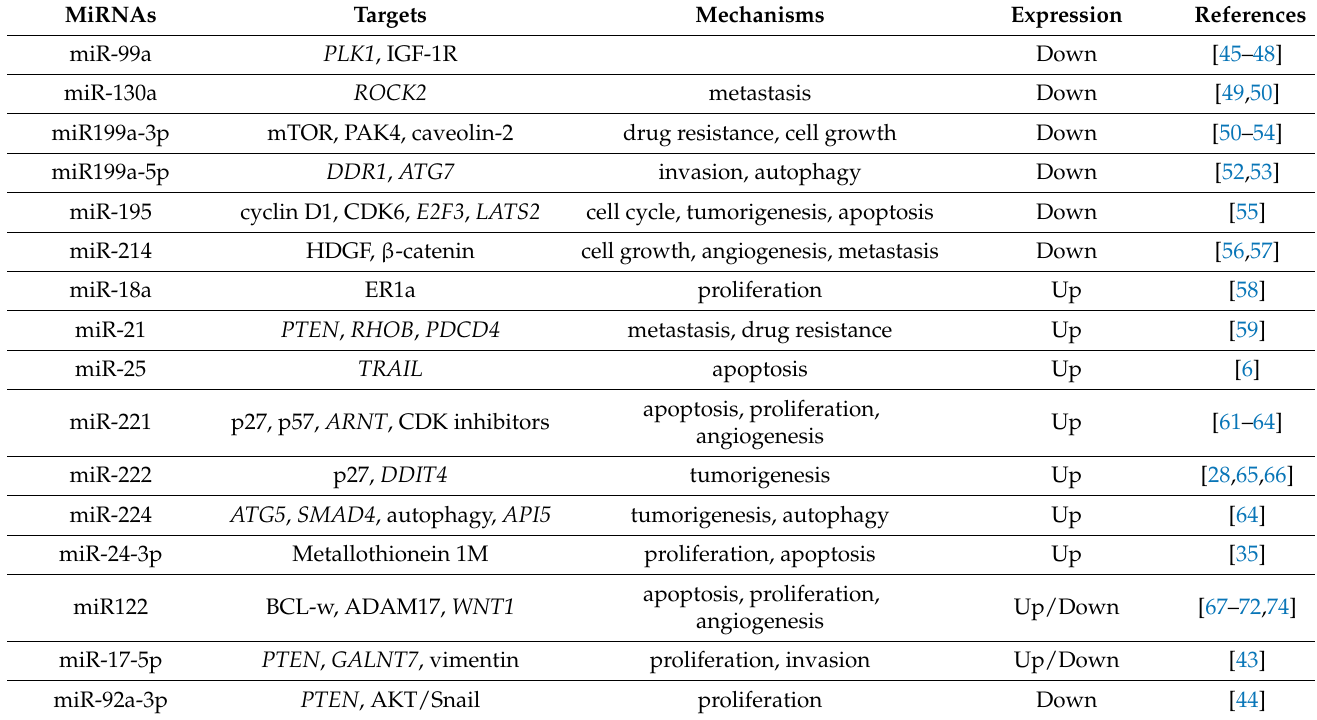
Table 1. Downregulated and upregulated circulating miRNAs in